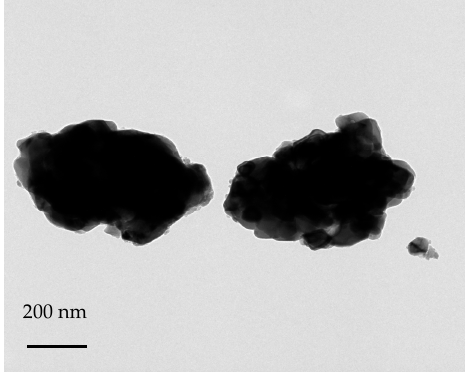
Figure 3. TEM image of the modified SrTiO 3 nanoparticles.